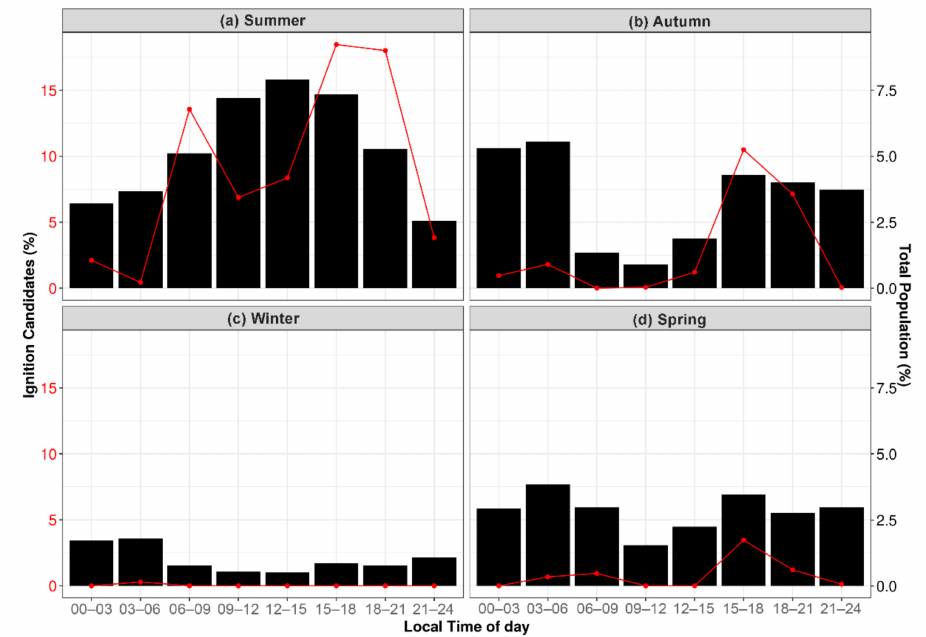
Figure 5. Diurnal distribution of total population of lightning strikes (%) (black histograms, right axis) compared to ignition candidate strikes (%) (red lines, left axis) across different seasons. Potential ignition candidates were selected by proximity index analysis as explained in Section